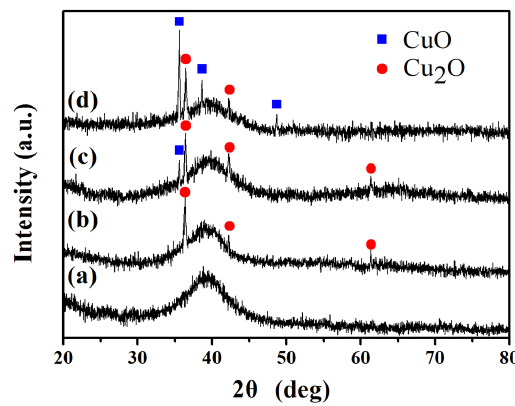
Figure 1. XRD patterns of dealloyed Cu-Hf-Al amorphous alloys in 0.5 M HCl solution for (a) 0 h, (b) 8 h, (c) 14 h, (d) 20 h.